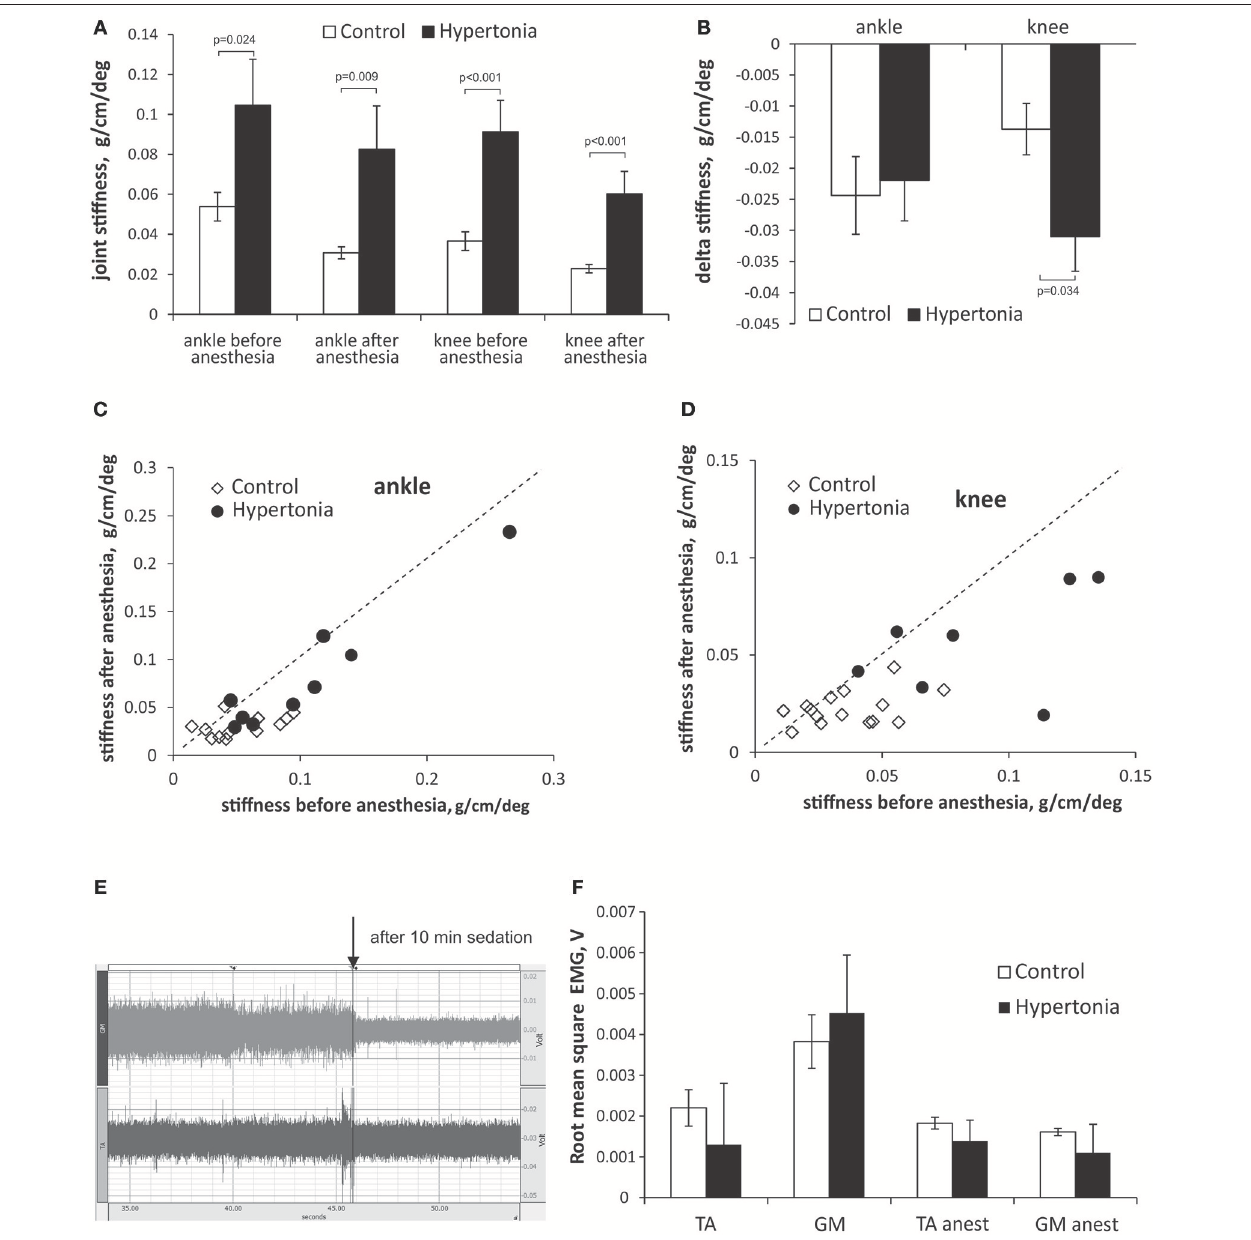
FIGURE 1 | Evaluation of passive and active components in increased muscle tone in kits after antenatal H-I. Muscle tone was assessed using passive joint stretch. Absolute (A) and delta change (B) of joint stiffness is calculated before and after anesthesia in P1 kits with and without hypertonia. Individual animal joint stiffness before anesthesia in ankles (C) and knees (D) is plotted on horizontal axes, and after anesthesia on vertical axes. Dotted line represents the identity line. (E) Electromyogram in ankle extensors (m. gastrocnemius, GM) and flexors (m. tibialis anterior, TA) in a period without limb movement recorded using intramuscular barbed wire electrodes. EMG trace is shown in a hypertonic P1 rabbit before and after anesthesia (indicated by arrow) with Ketamine/Xylazine. (F) Root mean square EMG (F) decreased with anesthesia in TA and GM. No difference was founds between control and hypertonia groups before and after anesthesia.